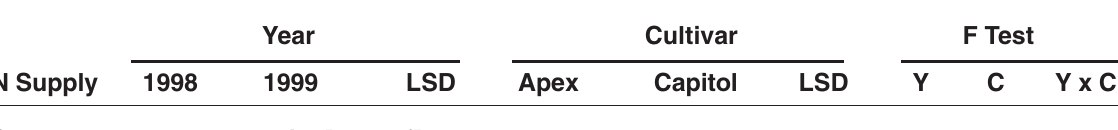
Shoot N Uptake at Maturity, N Uptake between Beginning of Flowering and Maturity, NHI, and N Utilization of Rape as Influenced by Year (Y), Cultivar (C), and N